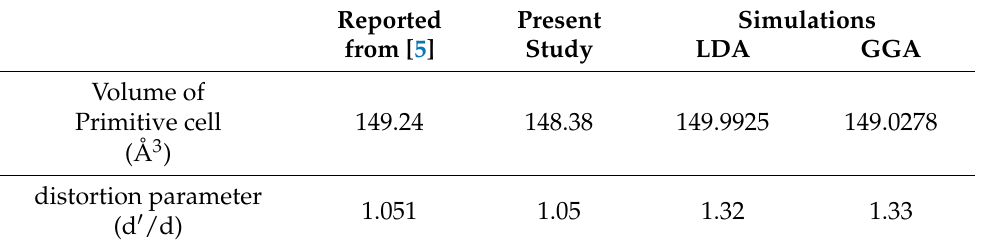
Table 2. Comparison of experimental and theoretical primitive cell volume together with the distor- tion parameter and the reported values from the